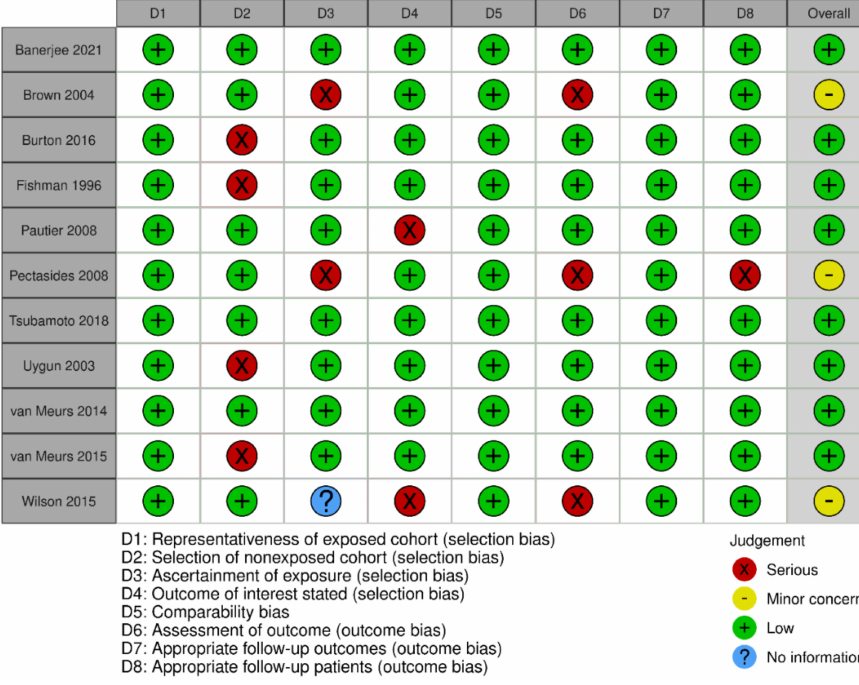
Figure A2. Risk of bias results in cohort studies using the NOS tool